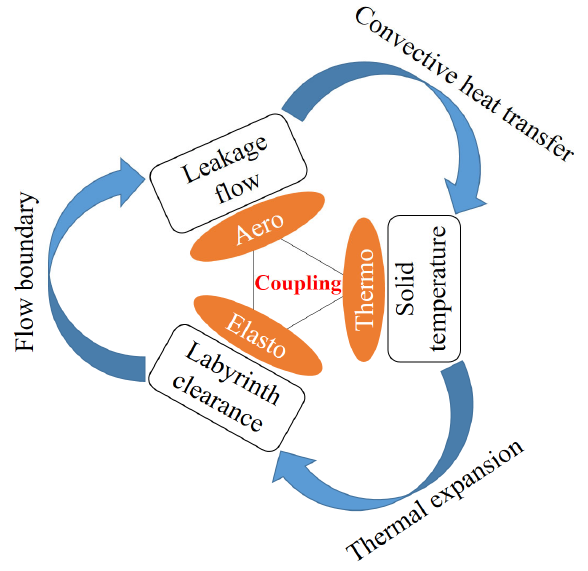
Figure 3. Multi-physics coupling relationship. Figure 3. Multi ‐ physics coupling relationship. Figure 3. Multi ‐ physics coupling relationship.